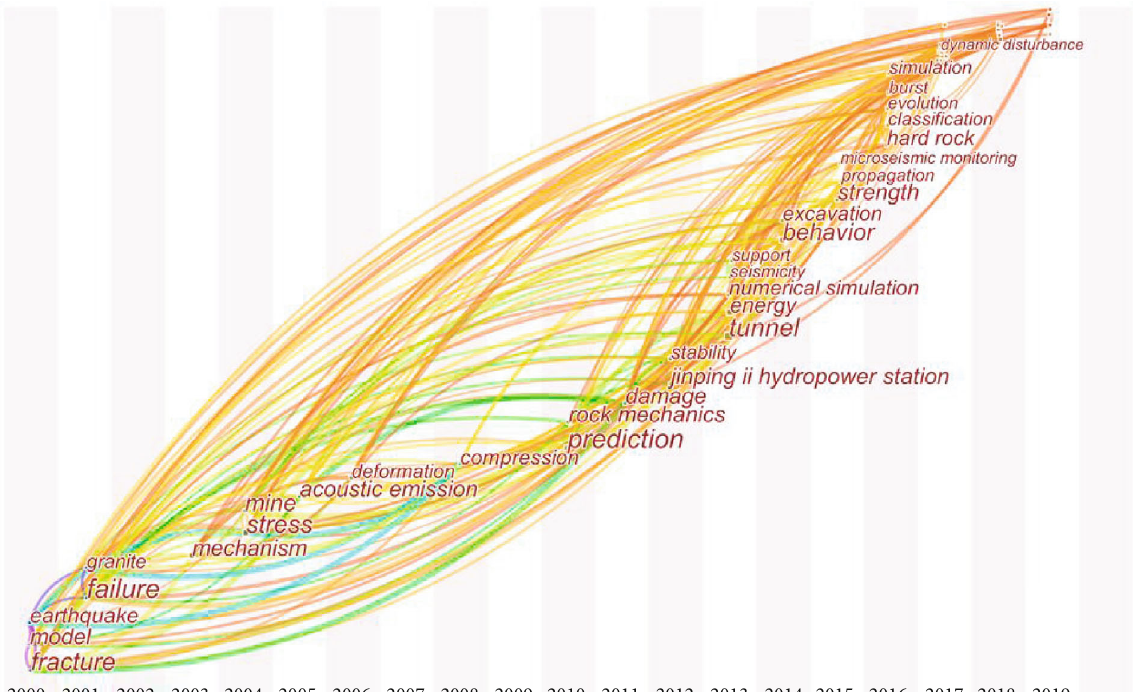
Figure 10: Time-zone view of the keyword cooccurrence